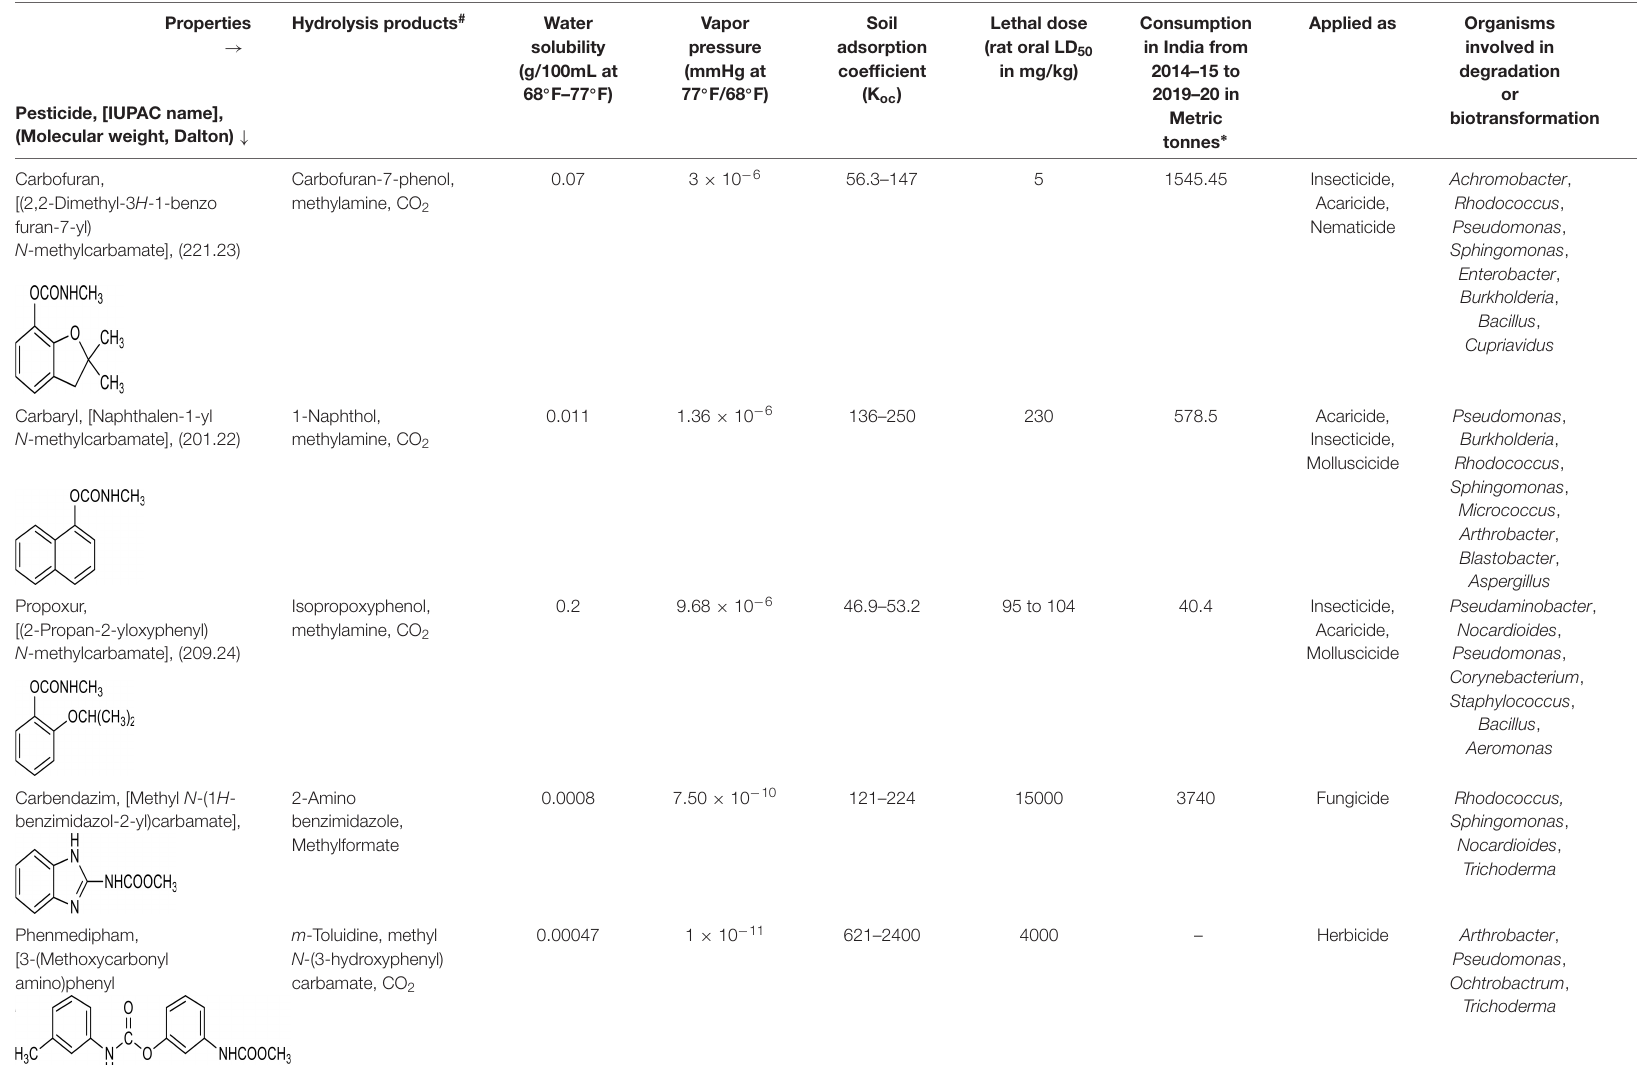
TABLE 1 | Physico-chemical properties of various carbamate pesticides and microbes involved in their degradation. Properties